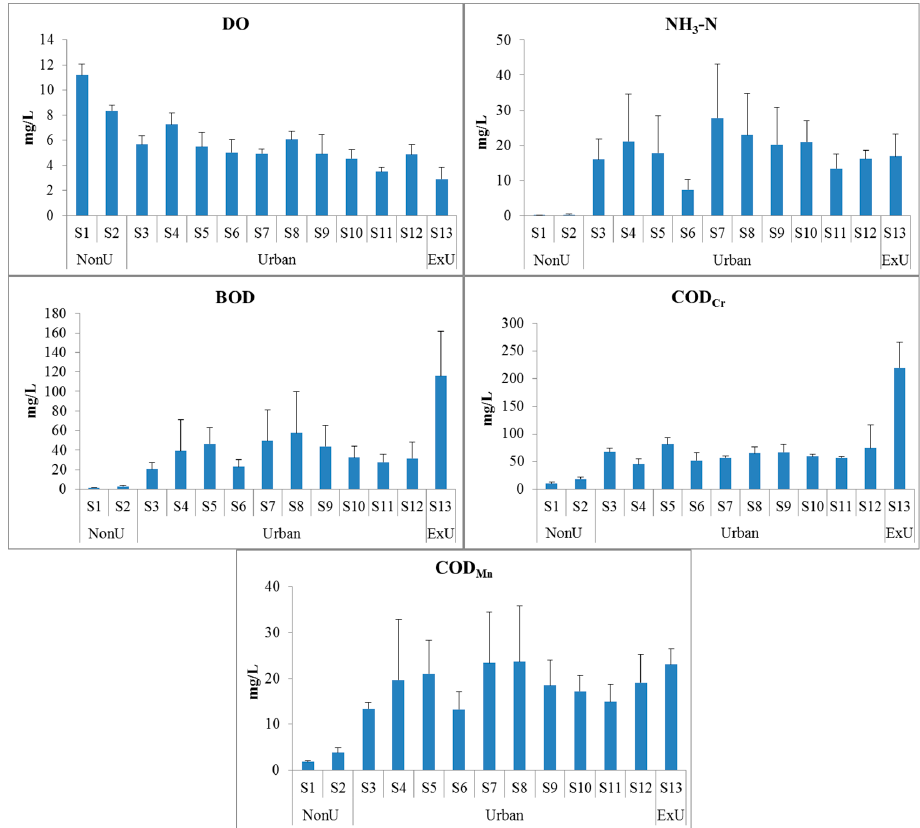
Figure 4. Spatial patterns of water quality in Beijing. The bars were the annual average concentrations for each station. “NonU” means nonurban sites; “ExU” means exurban sites. During the period of 2000–2010, water quality improved in Beijing, especially from 2005 to 2010 (Table 1). In urban areas, for example, the concentration of COD Mn decreased from 22.89 mg/L in 2000, to 18 mg/L in 2005, and to 11.72 mg/L in 2010 ( p < 0.01). BOD decreased from 58.82 mg/L in 2000, to 34.01 mg/L in 2005 ( p < 0.05), and to 22.39 mg/L in 2010 ( p < 0.01). Concentration of NH 3 -N and COD Cr also decreased in urban areas, but the concentration of DO increased from 4.87 mg/L in 2005 to 5.16 mg/L in 2010 ( p > 0.05). In exurban areas, the concentration of NH 3 -N, COD Cr , and COD Mn decreased from 2005 to 2010, and the concentration of DO increased from 2005 to 2010, however, the concentration of BOD increased from 2000 to 2010. In nonurban areas, the concentration of NH 3 -N, BOD, and COD Mn showed a fluctuating trend in 2000, 2005 and 2010. For example, the concentration of BOD decreased from 2.25 mg/L in 2000 to 1.9 mg/L in 2005, but increased to 2.35 mg/L in 2010, which was higher than 2000. COD Mn , however, the concentration increased from 1.95 mg/L in 2000 to 3.15 mg/L in 2005, but declined to 2.93 mg/L in 2010. Table 1. Mean value of water quality variables at nonurban areas, and urban areas and exurban areas in 2000, 2005, and 2010.